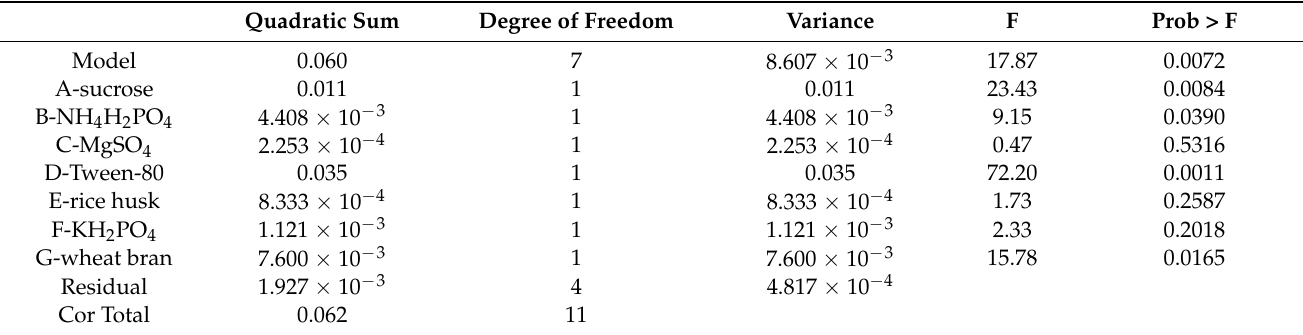
Table 5. Regression Equation F test table of this experiment.